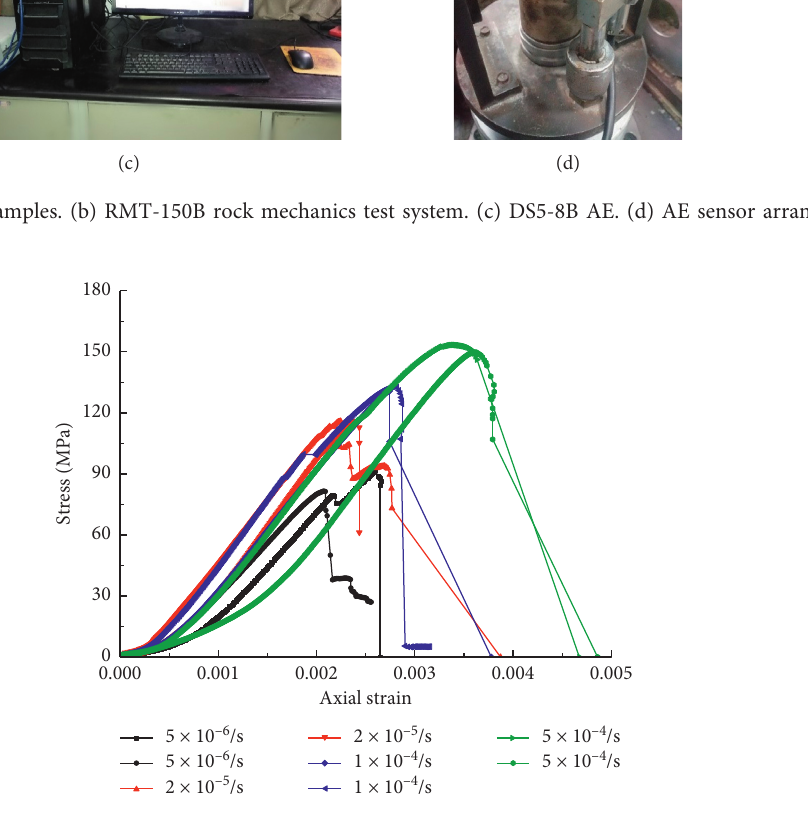
Figure 2: Stress-strain curves of the karst limestone under different strain rates. Table 1: Mechanical parameters of the karst limestone under different strain